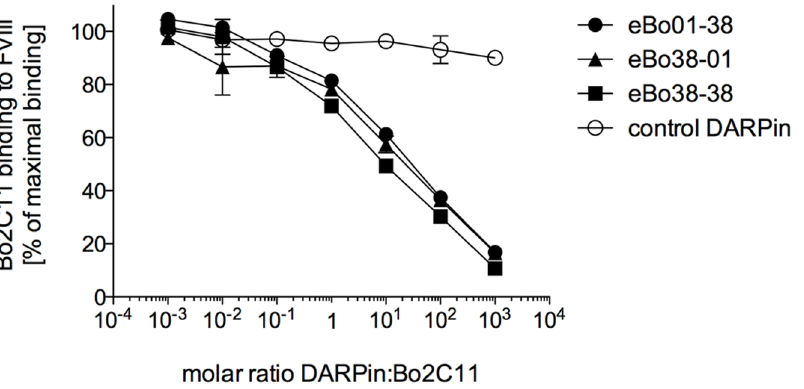
Figure 4. Bo2C11 binding to FVIII in presence of dimeric anti-FVIII antibody-specific DARPins. Inhibition of anti-FVIII antibody (Bo2C11) binding was performed at the EC 50 value of Bo2C11 on FVIII. 800 ng/ml Bo2C11 was mixed 1:1 with increasing concentrations of eBo01-38 (black circles), eBo38-01 (black triangles), eBo38-38 (black squares) or a dimeric DARPin of non-relevant specificity (open circles). The mixtures were pre- incubated at room temperature for 30 min and then added to FVIII-coated wells. The amount of Bo2C11 binding to FVIII was revealed with a horseradish-peroxidase-labeled anti-human IgG antibody. The results were normalized to 800 ng/ml Bo2C11 mixed 1:1 with buffer on FVIII. Data represent mean and standard deviation of duplicates. Shown is one representative of 3 individual experiments.